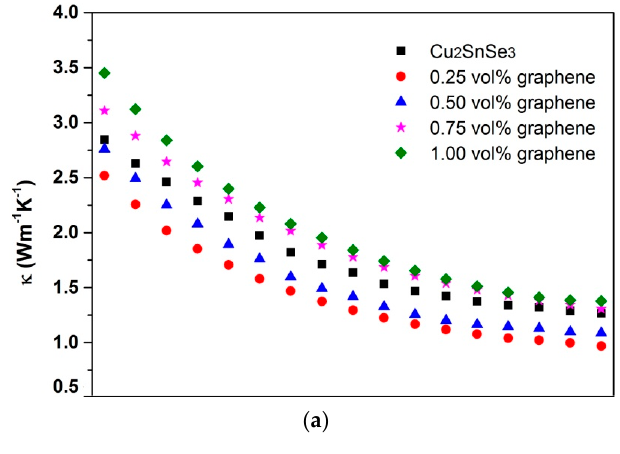
Figure 11b. By controlling the content of graphene nanosheets and microstructure of composites, the κ l of graphene/Cu 2 SnSe 3 composites may approach the region. Further optimization will be studied in further